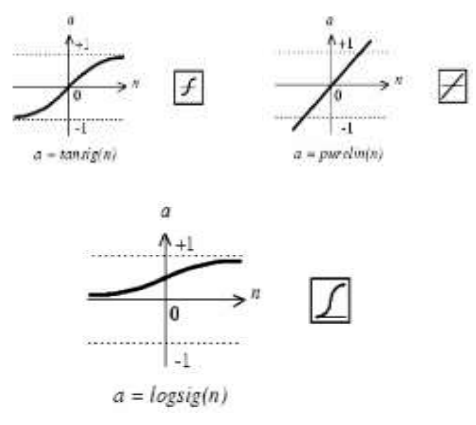
Figure 1. Transfer